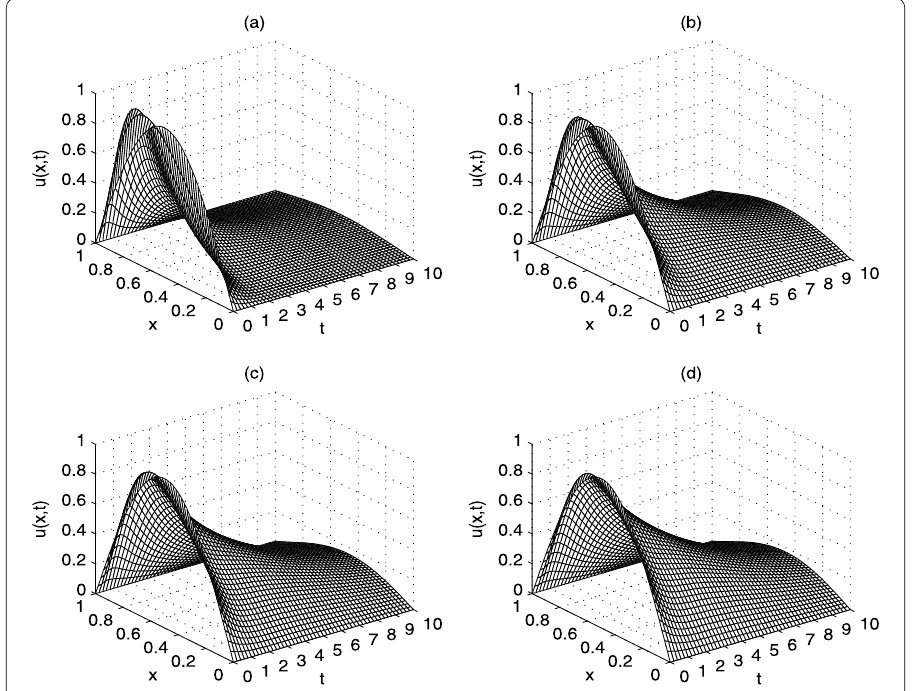
Figure 1 A 3-d landscape of the dynamics of the MGKdVB equation subject to boundary conditions (1.2)–(1.3); σ = 0.01, μ = 0.001, γ 1 = 1, γ 2 = 0.0005, and u 0 ( x ) = sin( π x ); ( a ) α = 1; ( b ) α = 2; ( c ) α = 3; ( d ) α =